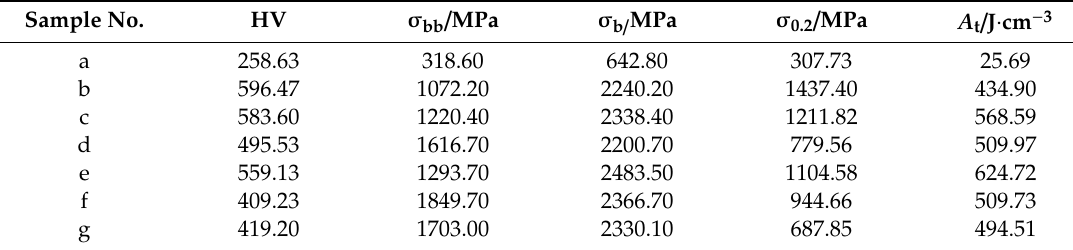
Figure 8. True stress–strain curves for compressive testing and schematic diagram of yield strength and compressive toughness for W-6Ni-4Co alloys by the di ff erent sintering processes: ( a ) 1200 ◦ C, 30 min; ( b ) 1450 ◦ C, 5 min; ( c ) 1450 ◦ C, 20 min; ( d ) 1450 ◦ C, 60 min; ( e ) 1500 ◦ C, 5 min; ( f ) 1500 ◦ C, 20 min; ( g ) 1500 ◦ C, 60 min. Table 4. Results of mechanical properties of W-6Ni-4Co alloy by the di ff erent sintering processes, such as microhardness (HV), flexural strength ( σ bb ), compressive strength ( σ b ), yield strength ( σ 0.2 ) and compressive toughness ( A t ).